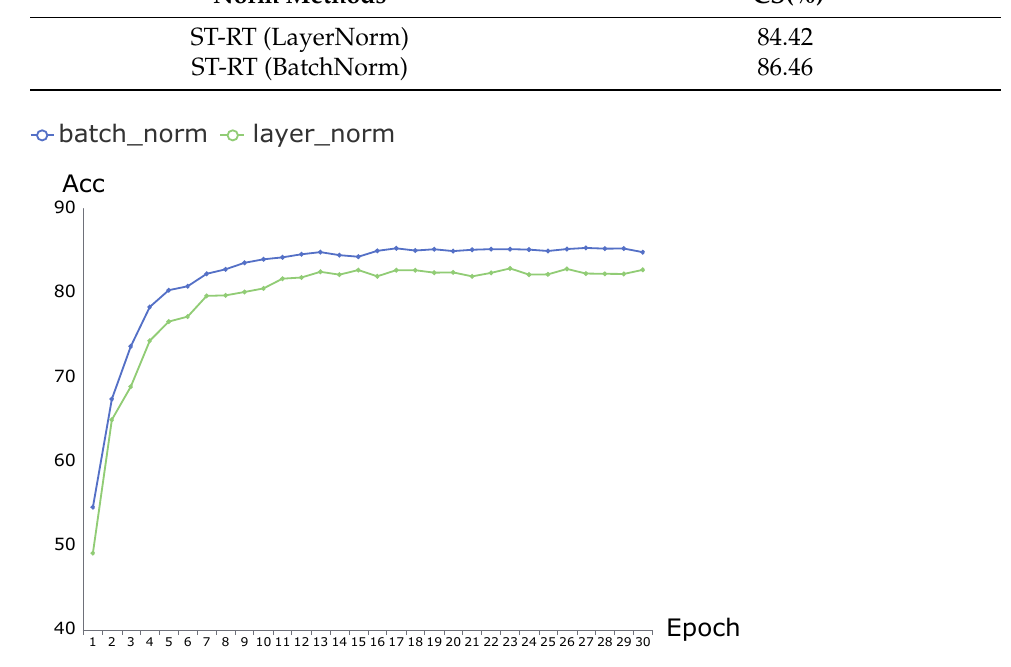
Figure 7. Difference in terms of accuracy and convergence speed between an ST-RT with batch normalization and an ST-RT with layer